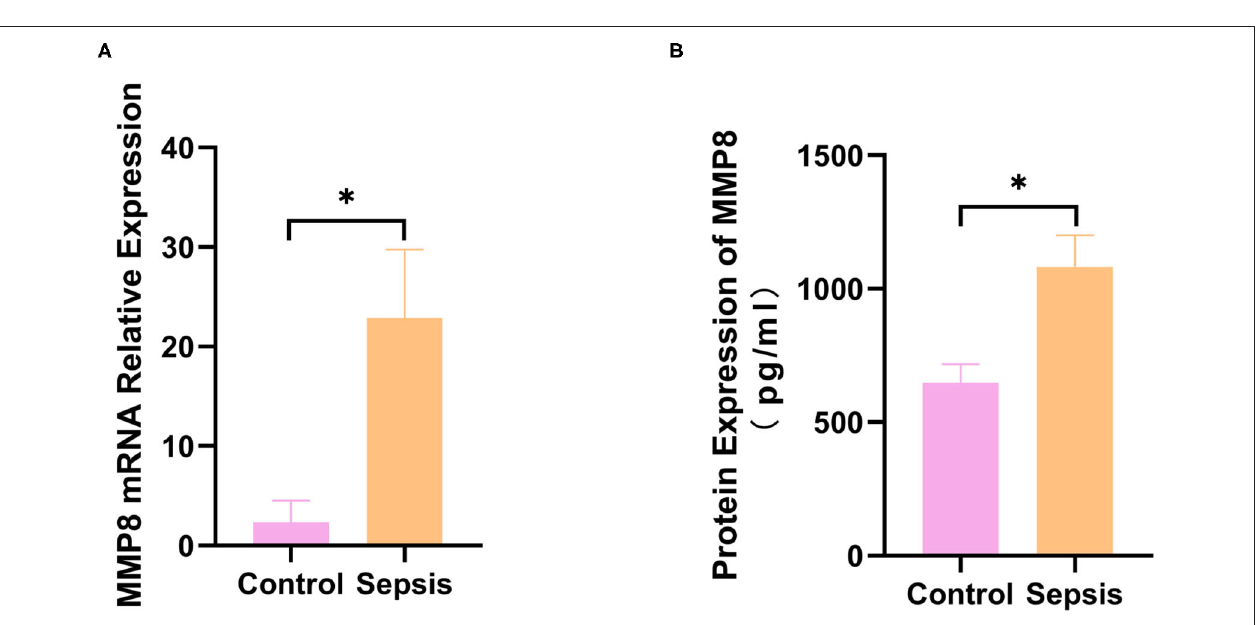
FIGURE 3 | Expression of MMP8 in blood samples from sepsis patients and controls. (A) mRNA expression of MMP8 in neutrophil of patients and controls was measured by q-RTPCR. (B) Protein level of MMP8 in serum of patients and controls was detected by ELISA. * p < 0.05 between control and sepsis group by using t